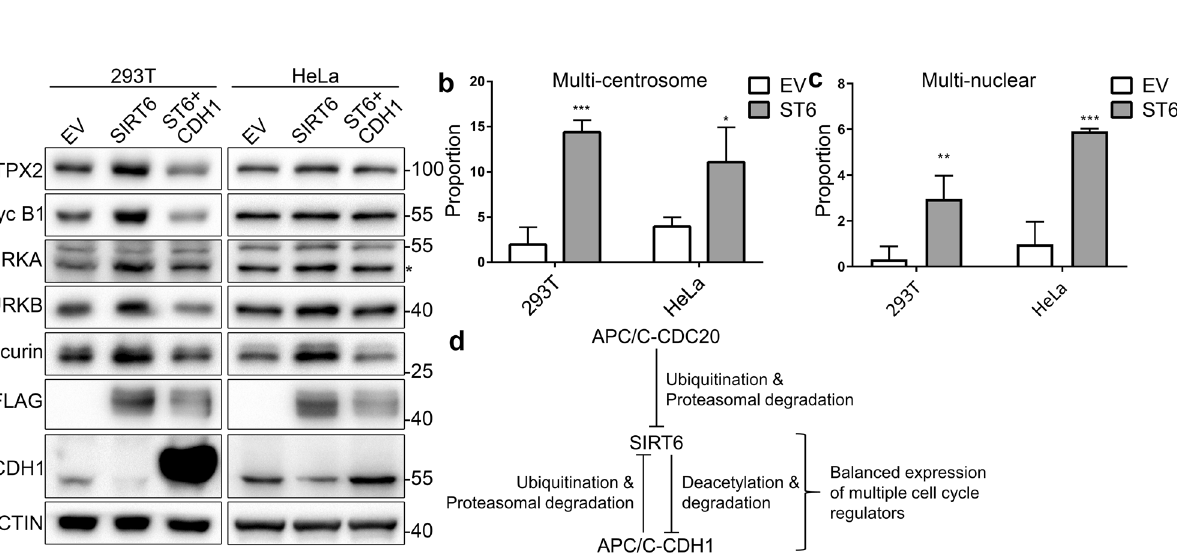
Figure 6. Overexpression of SIRT6 leads to up-regulation of various APC/C substrates and defective mitosis. ( a ) 293 T and HeLa cells stably expressing empty vehicle (EV), SIRT6-FLAG (SIRT6), SIRT6-FLAG, and CDH1-HA simultaneously (ST6 + CDH1) were treated with thymidine block and subjected to western blotting. Levels of TPX2, cyclin B1, AURKA, AURKB, securin, FLAG, and CDH1 were detected using the corresponding antibodies. Actin was used as a loading control. Short exposures of 293 T CDH1 are shown in the original image section of the supplementary file. ( b ) Proportions of cells with three centrosomes or more were counted in control and SIRT6 overexpressing 293 T and HeLa cells (n = 100). ( c ) Proportions of cells with two or more nuclears were counted in control and SIRT6 overexpressing 293 T and HeLa cells (n = 100). ( d ) Mechanistic illustration of the current